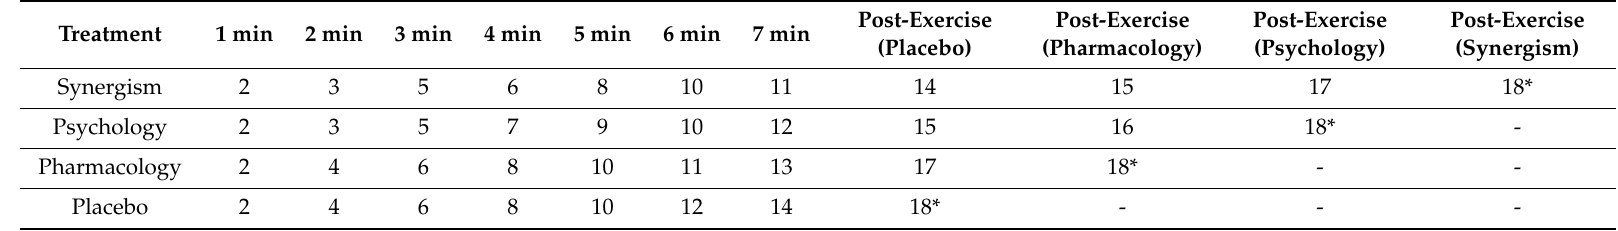
Table 1. Post-exercise ratings of perceived exertion (RPE) divided by T LIM per min (exercise termination across treatments advocated by